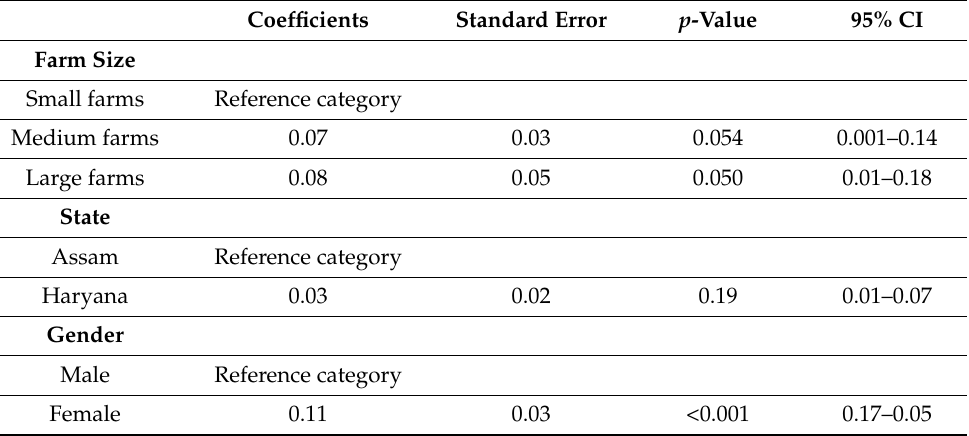
Table 3. Multivariable regression results of knowledge score, normalized with Cronbach’s alpha, with farm size, state, and